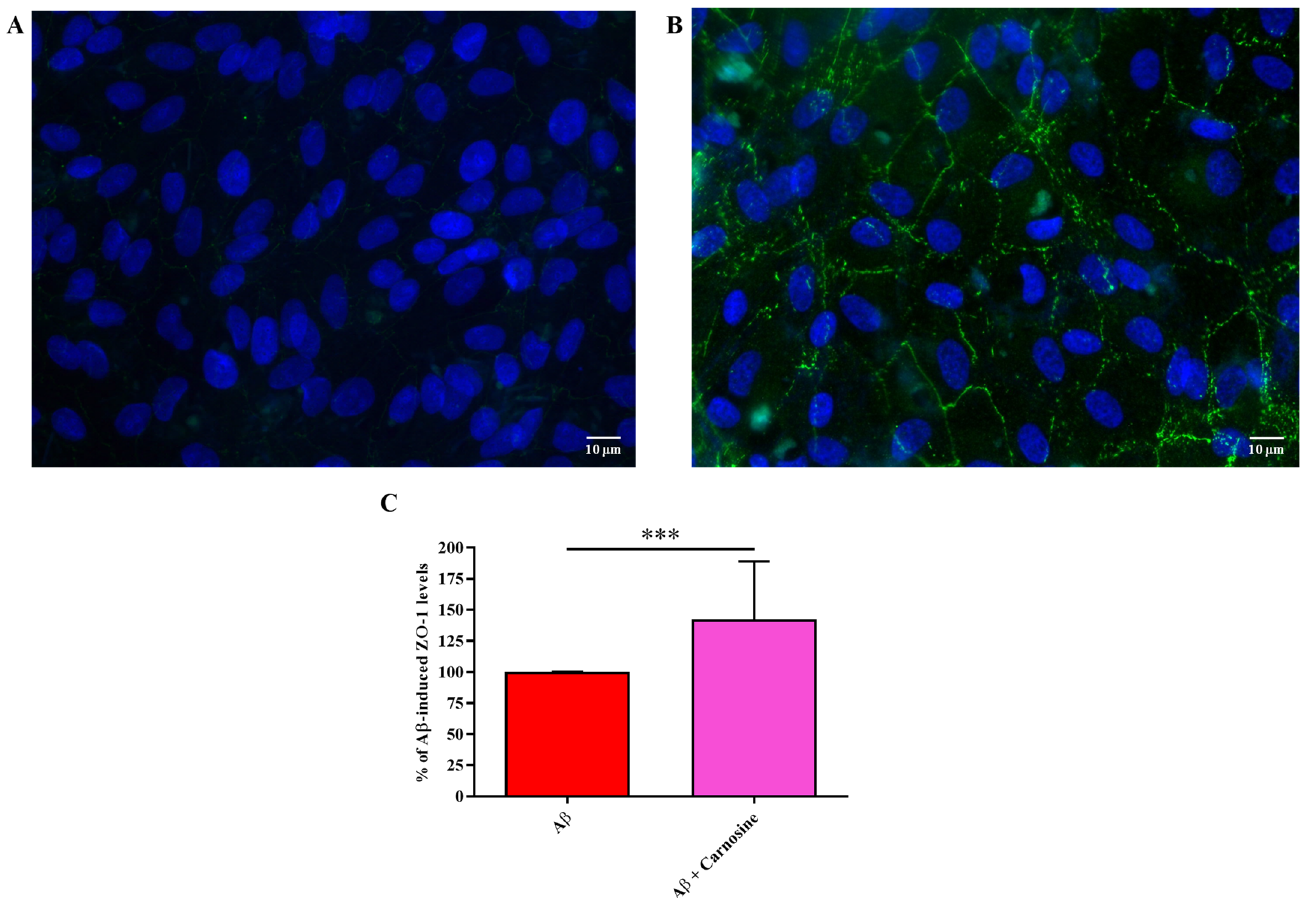
Figure 5. Immunocytochemistry evaluation of ZO-1 staining in ARPE-19 cells exposed to A β 1-42 oligomers (2 µM) for 48 h in the ( A ) absence or ( B ) presence of carnosine (20 mM; 1 h pre-treatment). ( C ) The average intensity (AU) of the data from more than 10 values per coverslip for ZO-1 under our experimental conditions is shown and expressed as the percent variation with respect to ZO-1 expression levels in A β 1-42 oligomers-treated cells. Standard deviations are represented by vertical bars. ZO-1 was labeled with FITC (green), while nuclei were labeled with DAPI (blue). *** significantly different, p < 0.001.